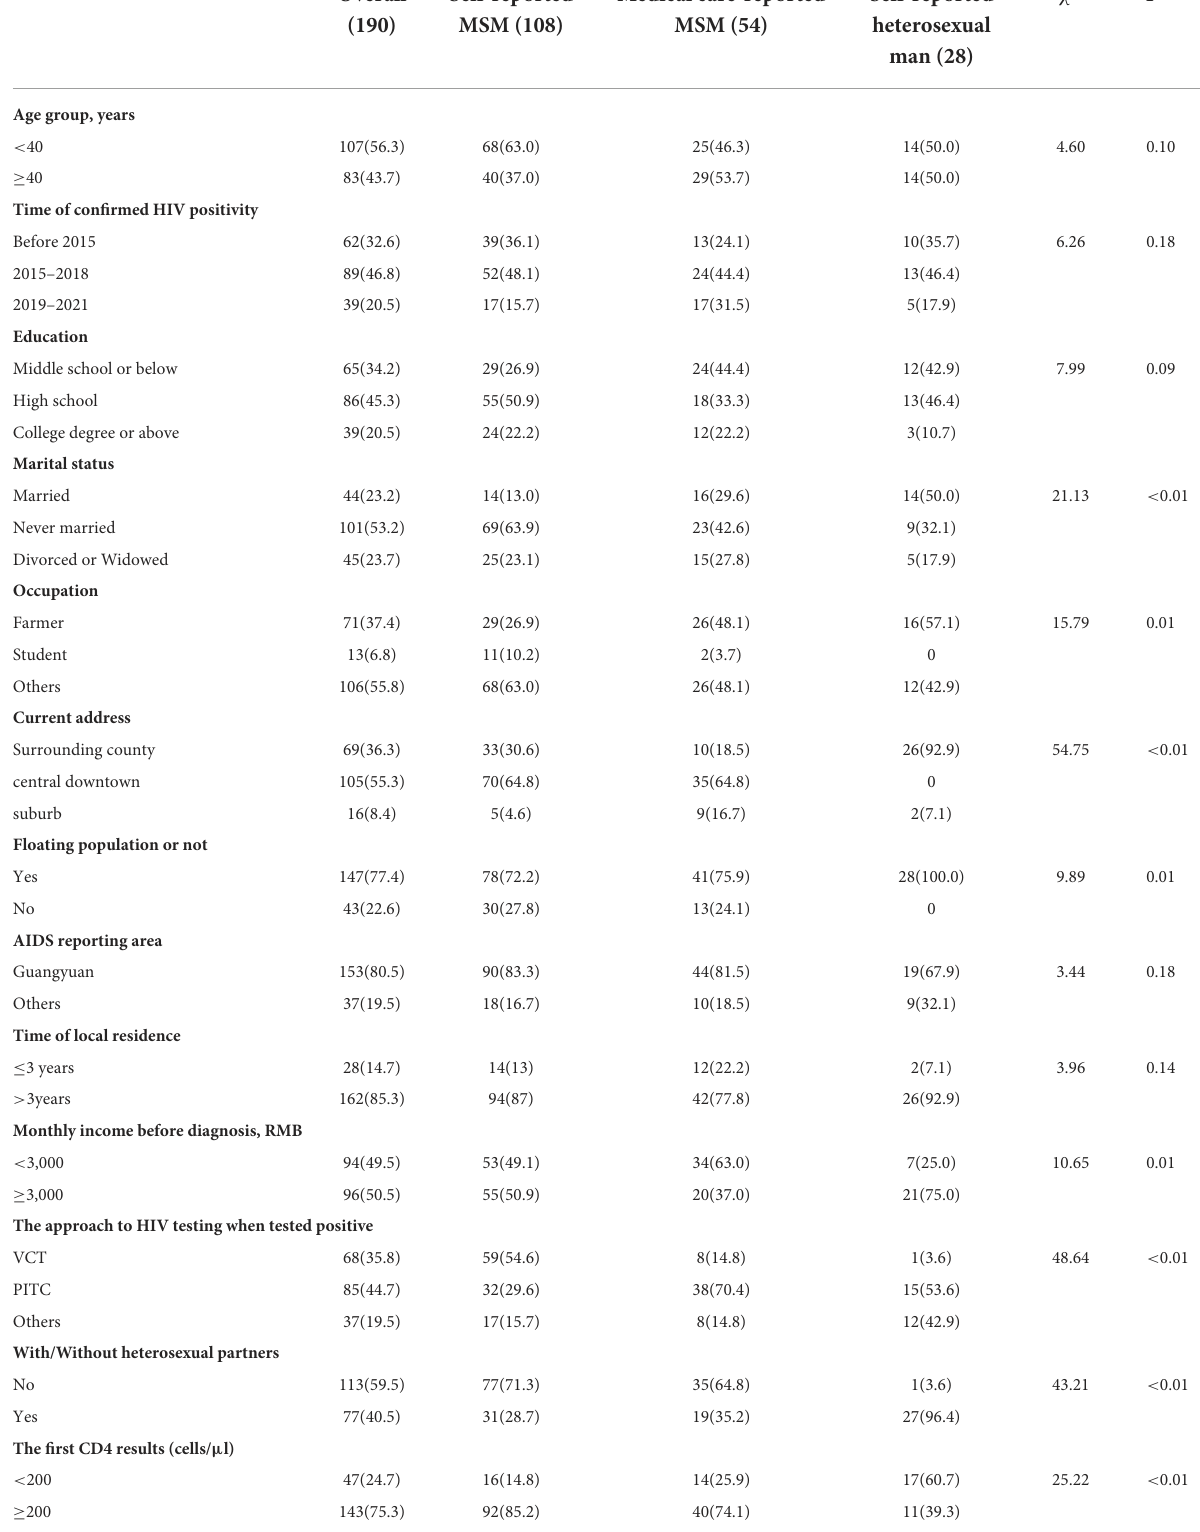
TABLE 1 Demographic characteristics and attitudes toward MSM among pMSM (%). Overall (190)